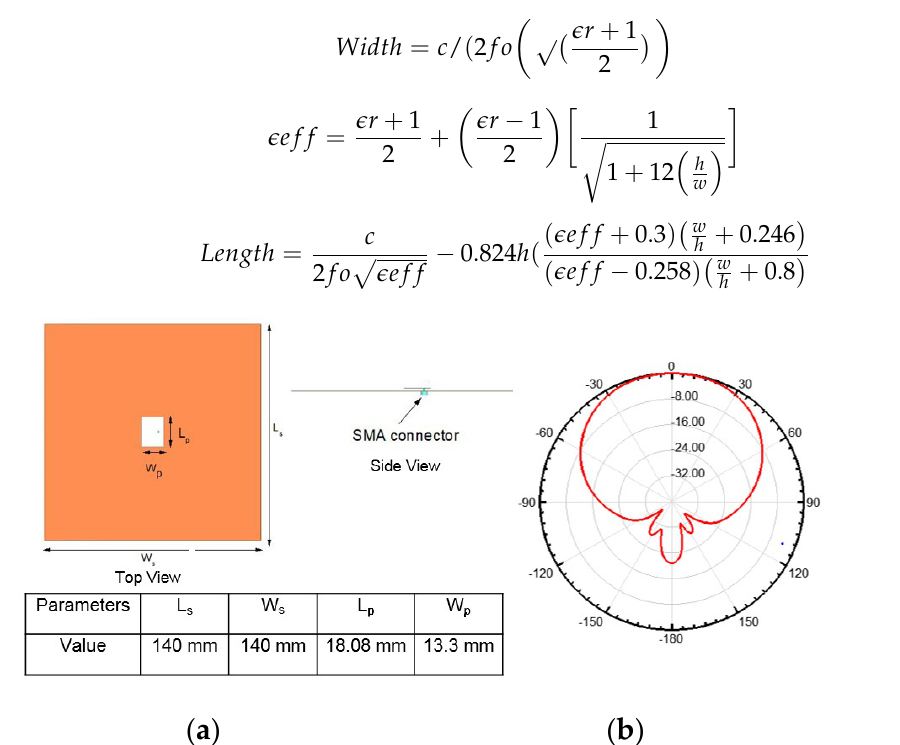
Figure 2. ( a ) Coaxial feed patch antenna ( b ) Boresight rediation